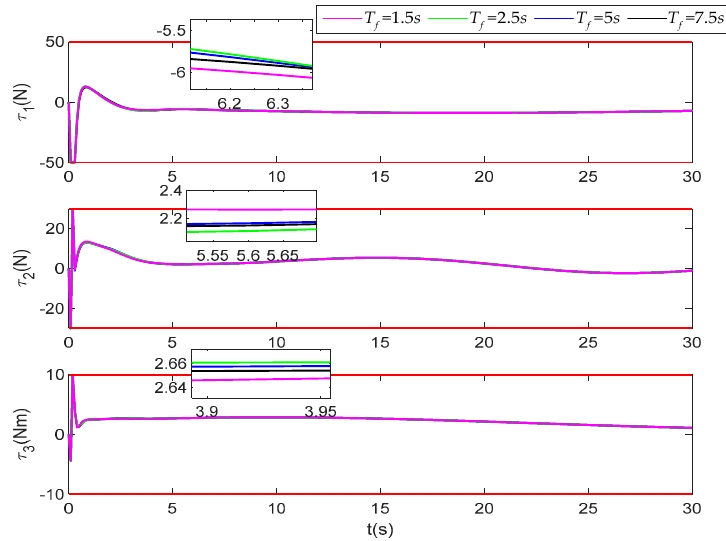
Figure 23. Control input under different settling time.